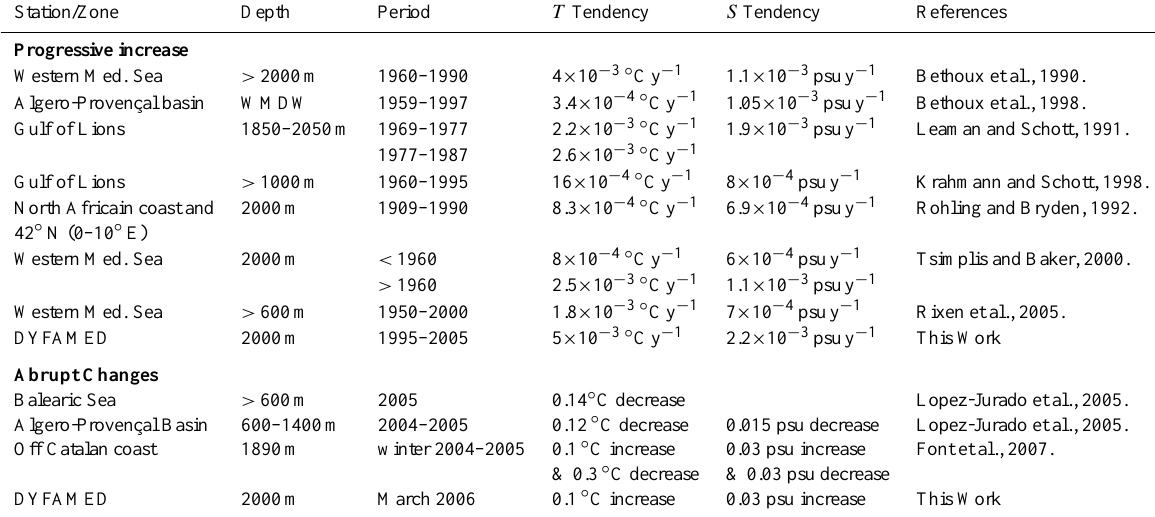
Table 1. Literature review of the estimates of annual increases and abrupt changes in potential temperature and salinity of the WMDW. Station/Zone